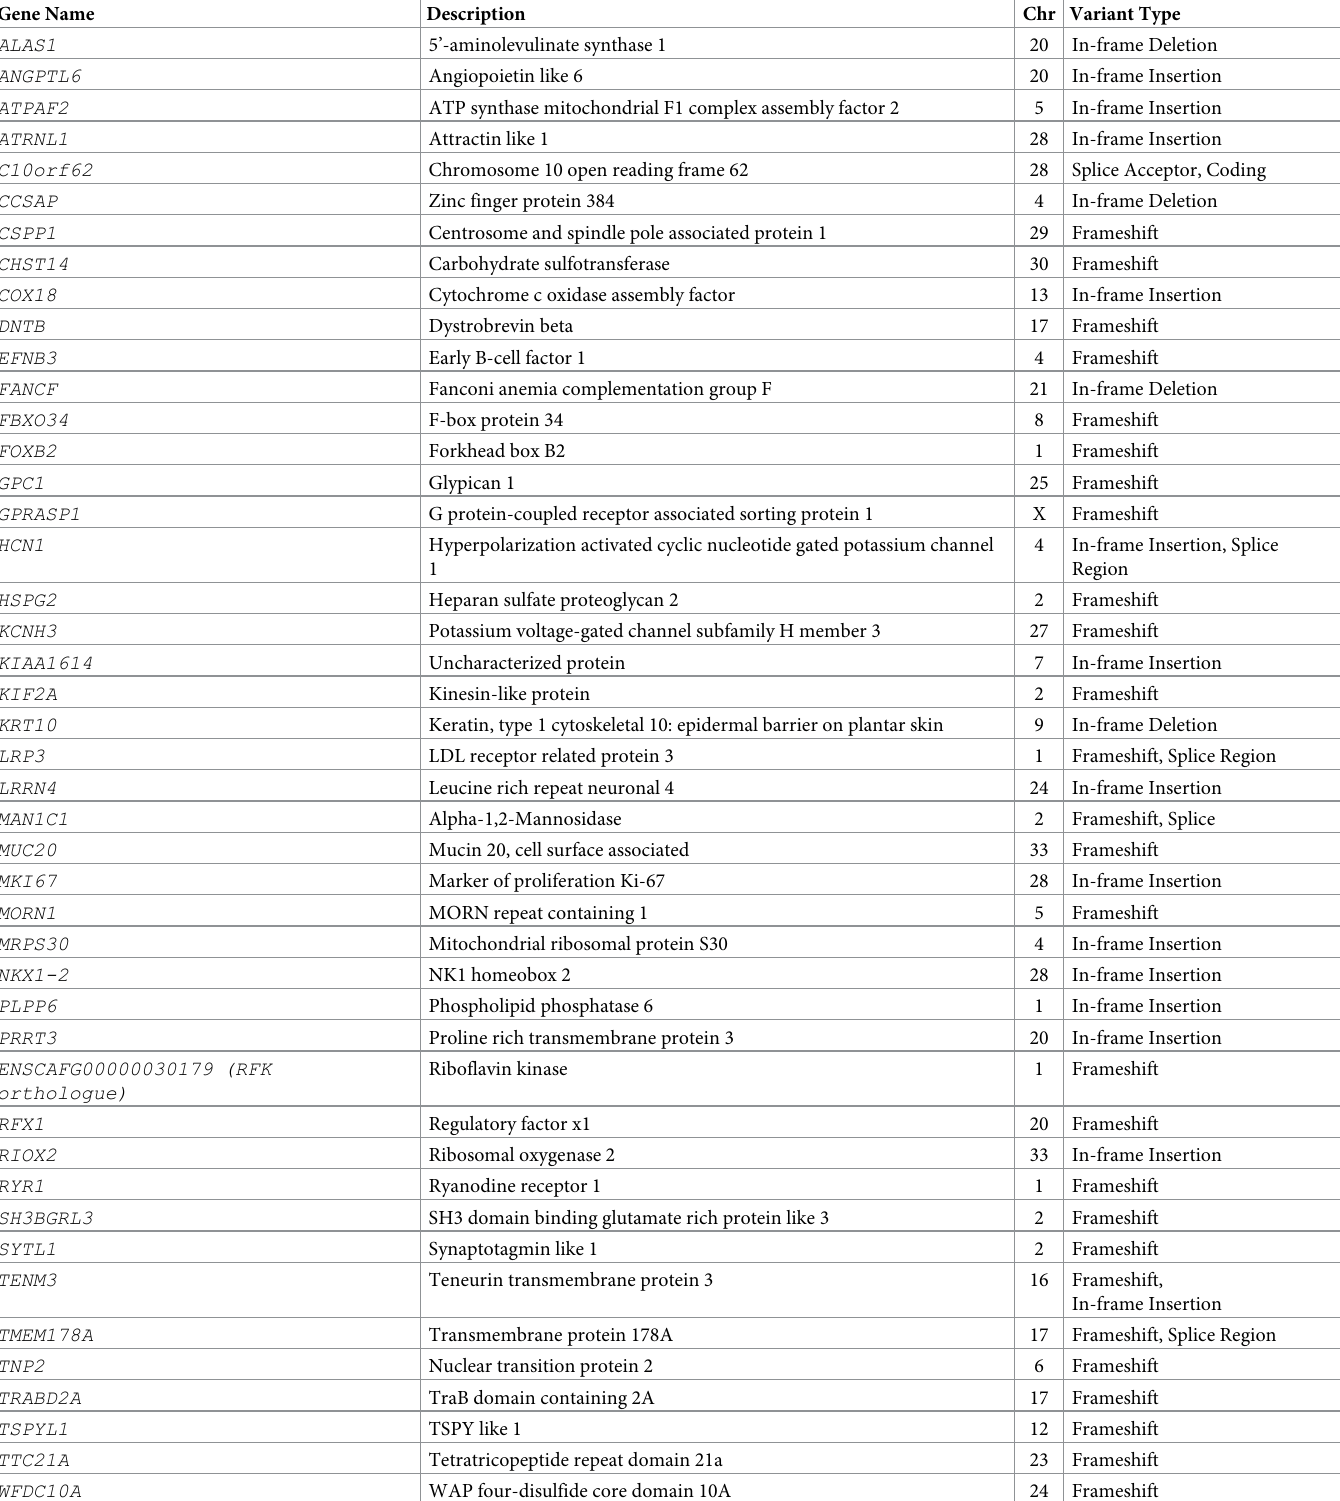
Table 3. High/moderate impact genes with variants not previously identified in canine